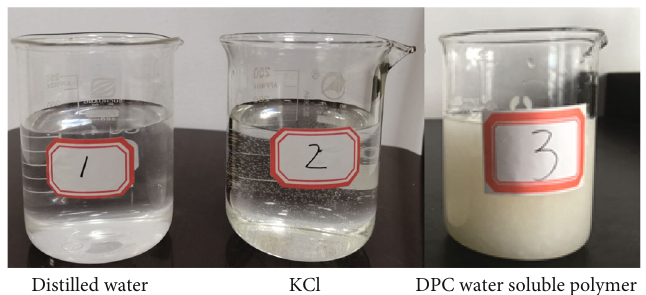
Figure 3: Working fl uids.